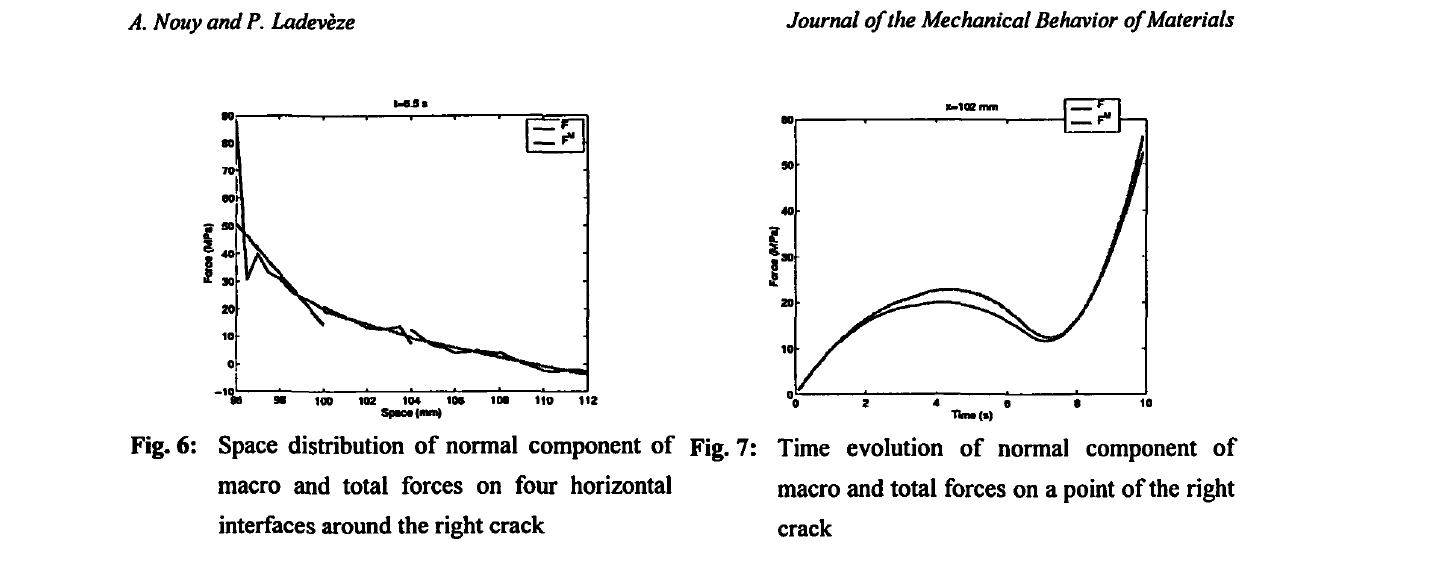
Fig. 6: Space distribution of normal component of Fig. 7: Time evolution of normal component of macro and total forces on four horizontal macro and total forces on a point of the right interfaces around the right crack crack